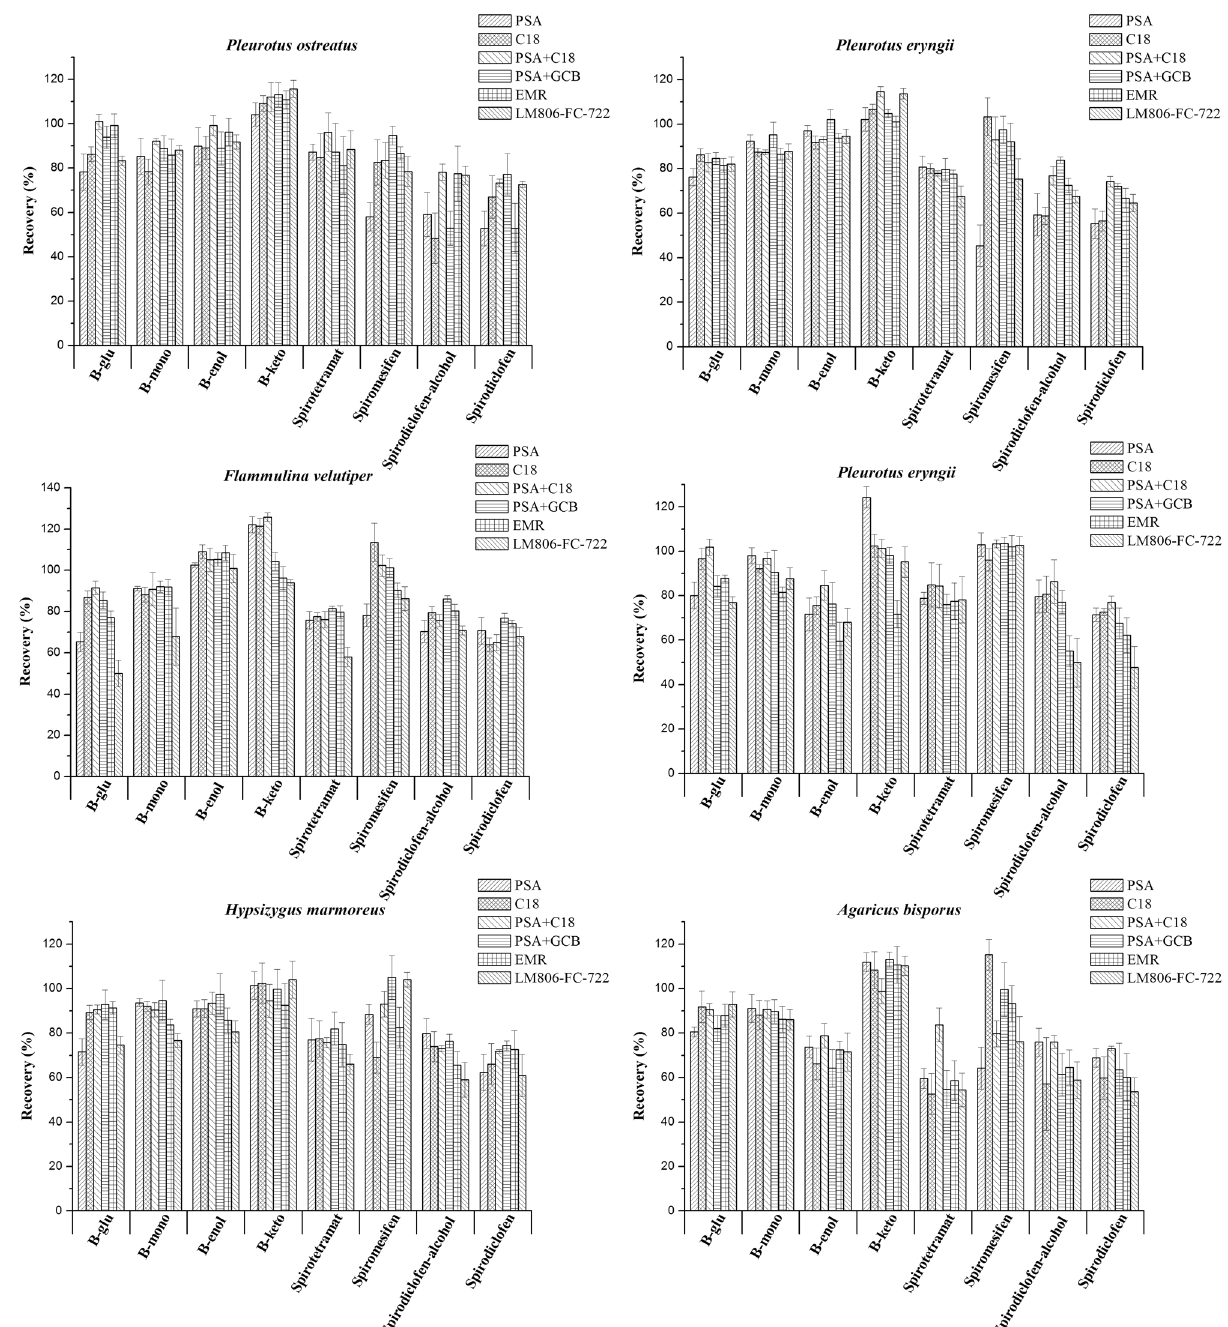
Figure 3. Effect of different sorbents for spirodiclofen, spiromesifen, and spirotetramat and their relevant metabolites in different edible fungi matrix at 100 μg kg −1 level (n =